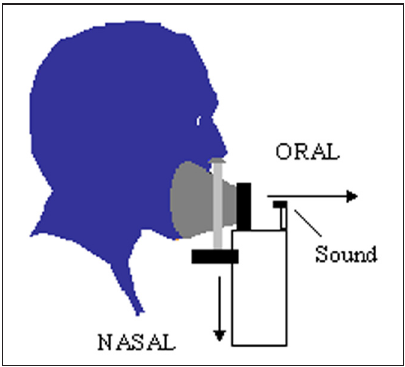
Figure 1: Subject position to record acoustic and aerodynamic data with the EVA. Source: SQLab